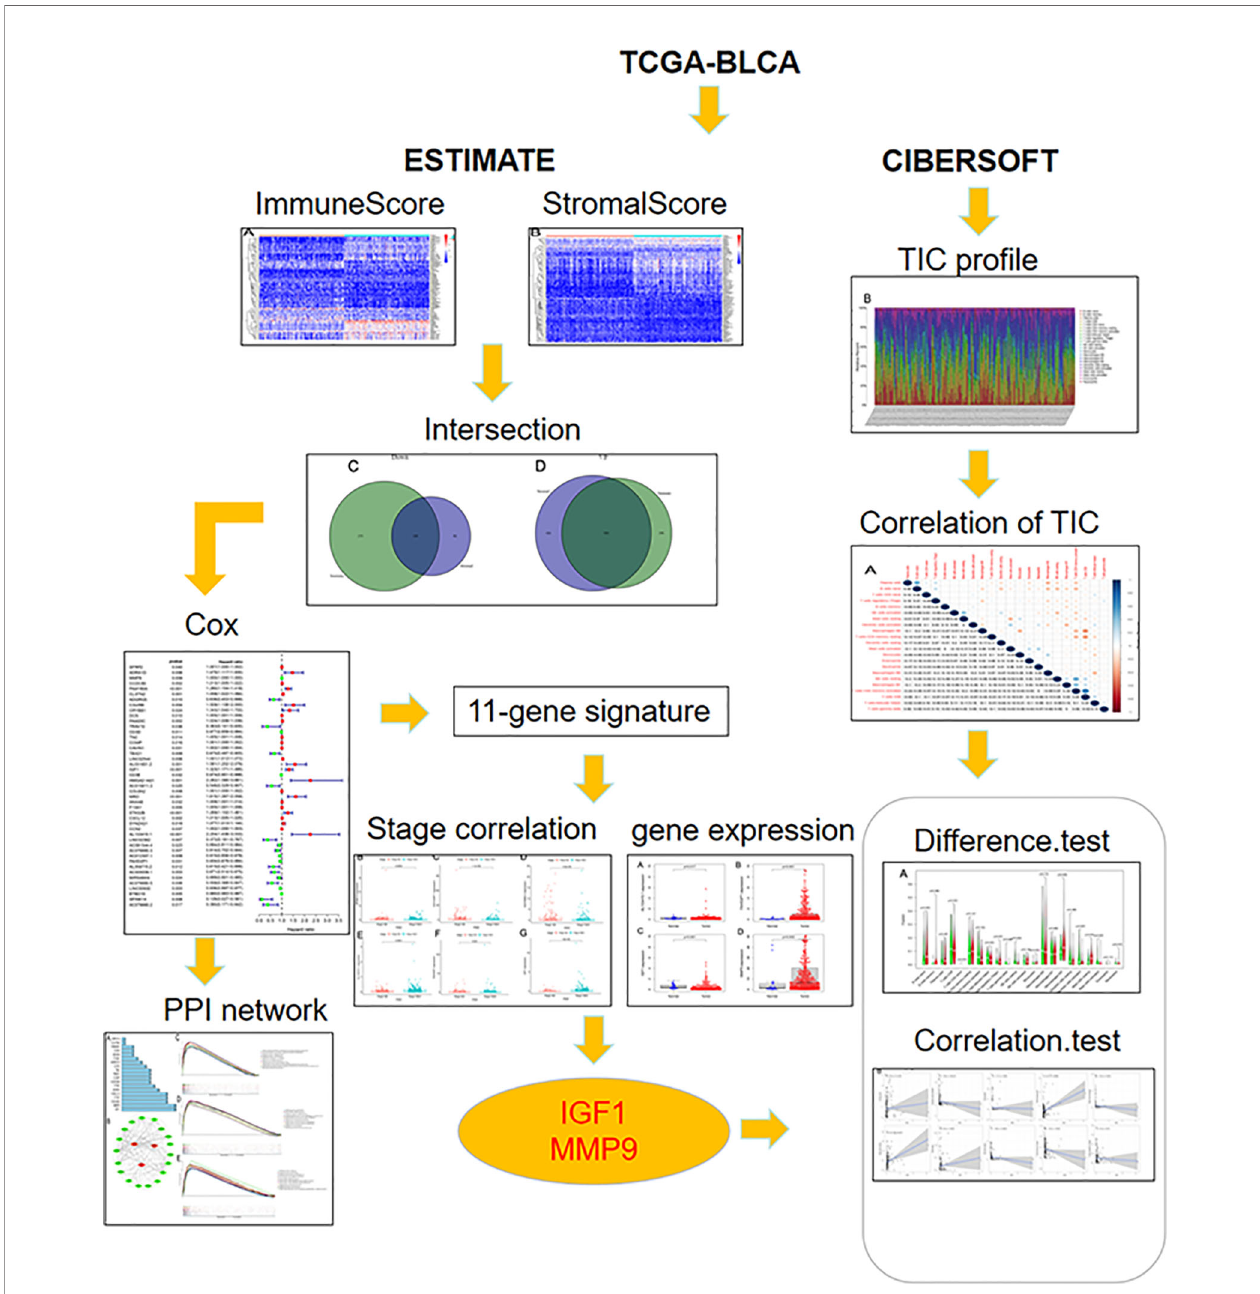
FIGURE 1 | The overall work fl ow of this